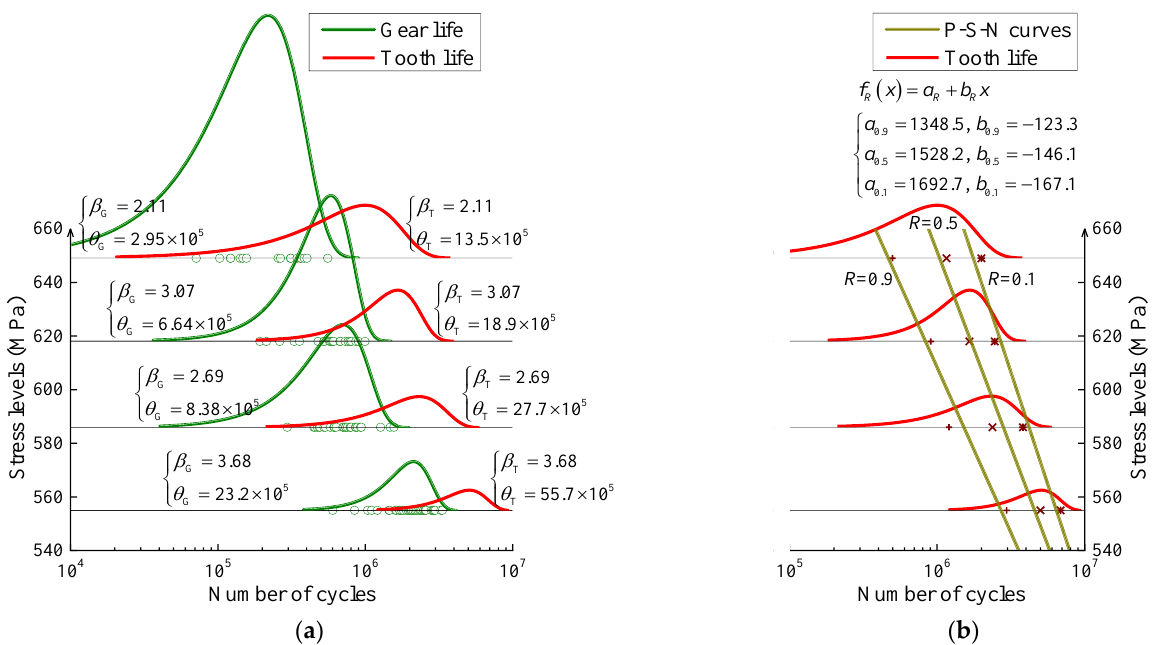
Figure 16. Statistical transformation of test data: ( a ) probability life transformation for tooth; ( b ) P-S-N curves fitting for tooth.